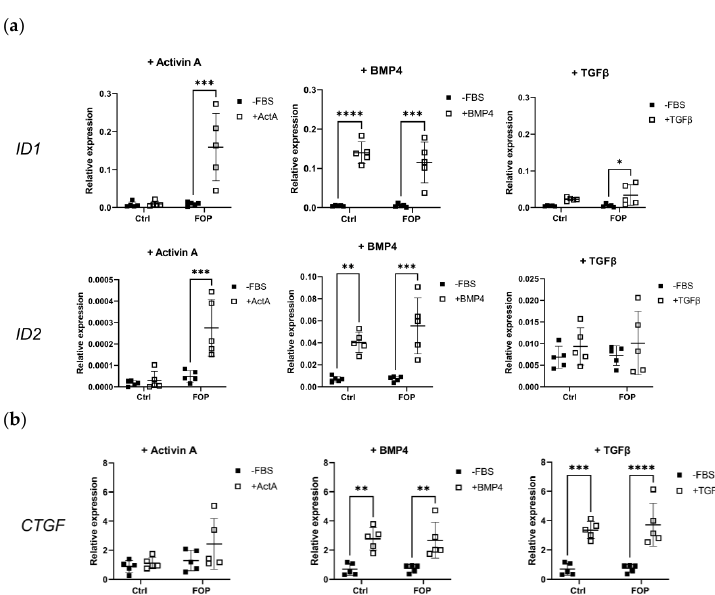
Figure 4. Relative gene expression of BMP and TGFβ target genes. Fibroblasts from 5 FOP and 5 control cell lines were serum-starved overnight (-FBS) before treatment with Activin A (+Activin A), BMP4 (+BMP4) and TGFβ1 (+TGFβ) for 6 h. Relative gene expression was measured by qPCR for ( a ) BMP target genes ID1 and ID2 and ( b ) TGF β target gene CTGF ; YWHAZ was used to normalize gene expression. − FBS indicates cells in medium without fetal bovine serum. Data is shown as the expression levels per cell line and their mean. * p < 0.05, ** p < 0.005, *** p < 0.0005, **** p < 0.00005 as determined by 2-way ANOVA.